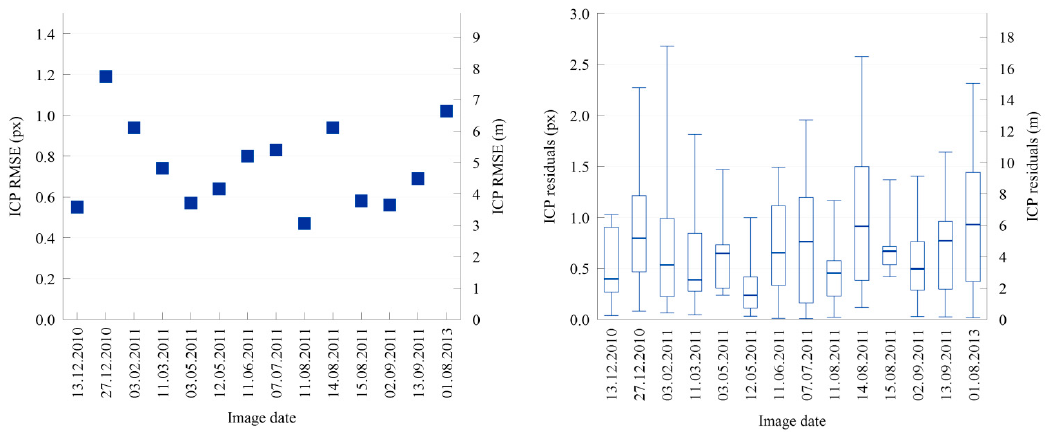
Figure 11. Independent check point (ICP) RMSE in pixels/meters ( left ) and boxplots of corresponding ICP residuals ( right ) for 14 RapidEye level 1B images processed with the physical sensor model. Images are referenced by dates. Most values are under one pixel, except for one winter image and the mountainous image where the values are slightly higher. Table 4. Root-mean-square error (RMSE) values for 14 RapidEye level 1B images processed with the physical sensor model. The number of GCPs was reduced by RANSAC and further refined by robust estimation. Independent check points (ICPs) were manually digitized.